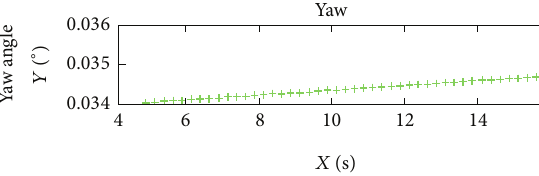
Figure 3: The attitude angle (Roll) curve in 10 seconds.